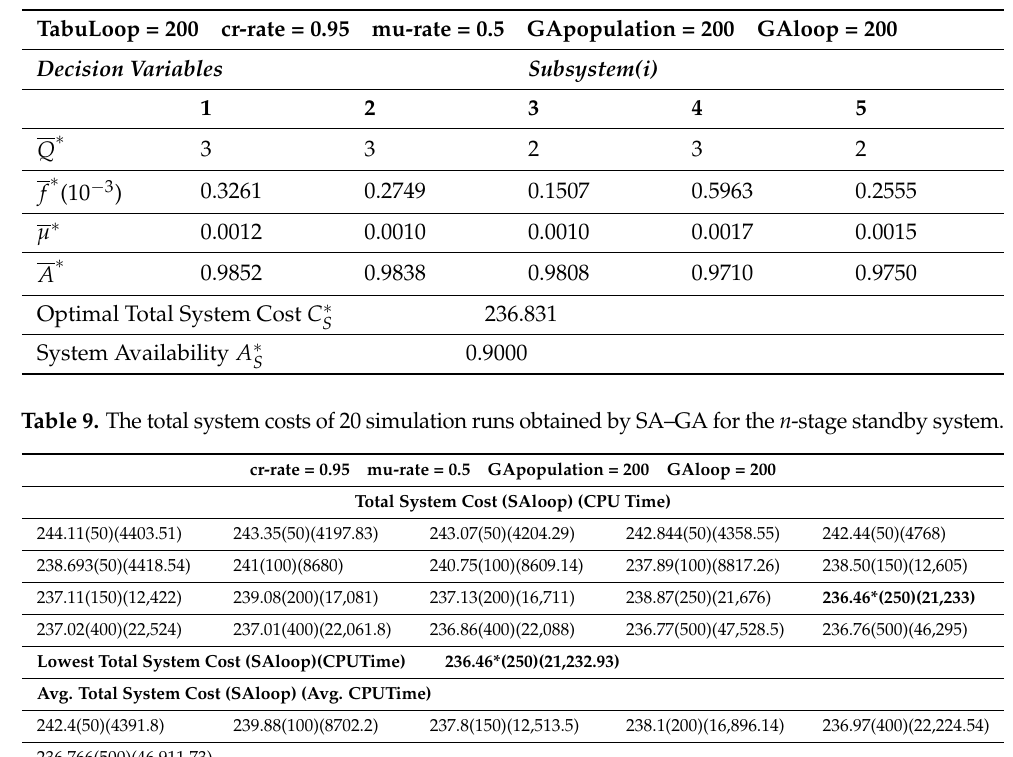
Table 8. Optimal Solutions obtained by TS–MGA for the n -stage standby system.